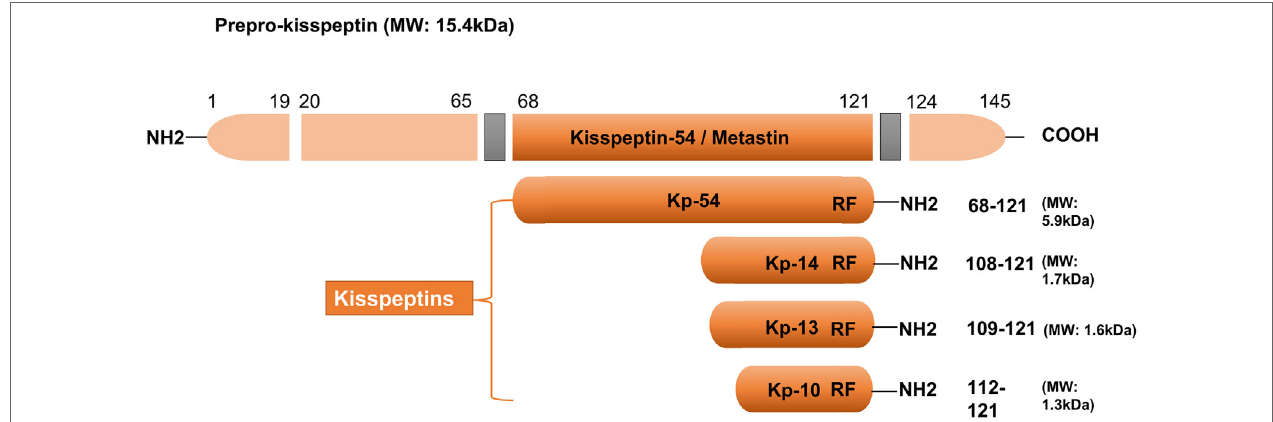
FigURe 1 | Major structural features of human kisspeptins, the products of the Kiss1 gene. Different kisspeptins are generated by the cleavage from a common precursor, the prepro-kisspeptin. The prepro-kisspeptin contains 145 amino acids, with a 19-amino acid signal peptide and a central 54-amino acid region, kisspeptin-54 (Kp-54; formerly termed as metastin). Further cleavage of metastin generates kisspeptins of lower molecular weight: kisspeptin-14 (Kp-14), Kp-13, and Kp-10. All kisspeptins contain the RF-amide motif that is able to bind and activate kisspeptin receptor. Modified from Ref. (6).